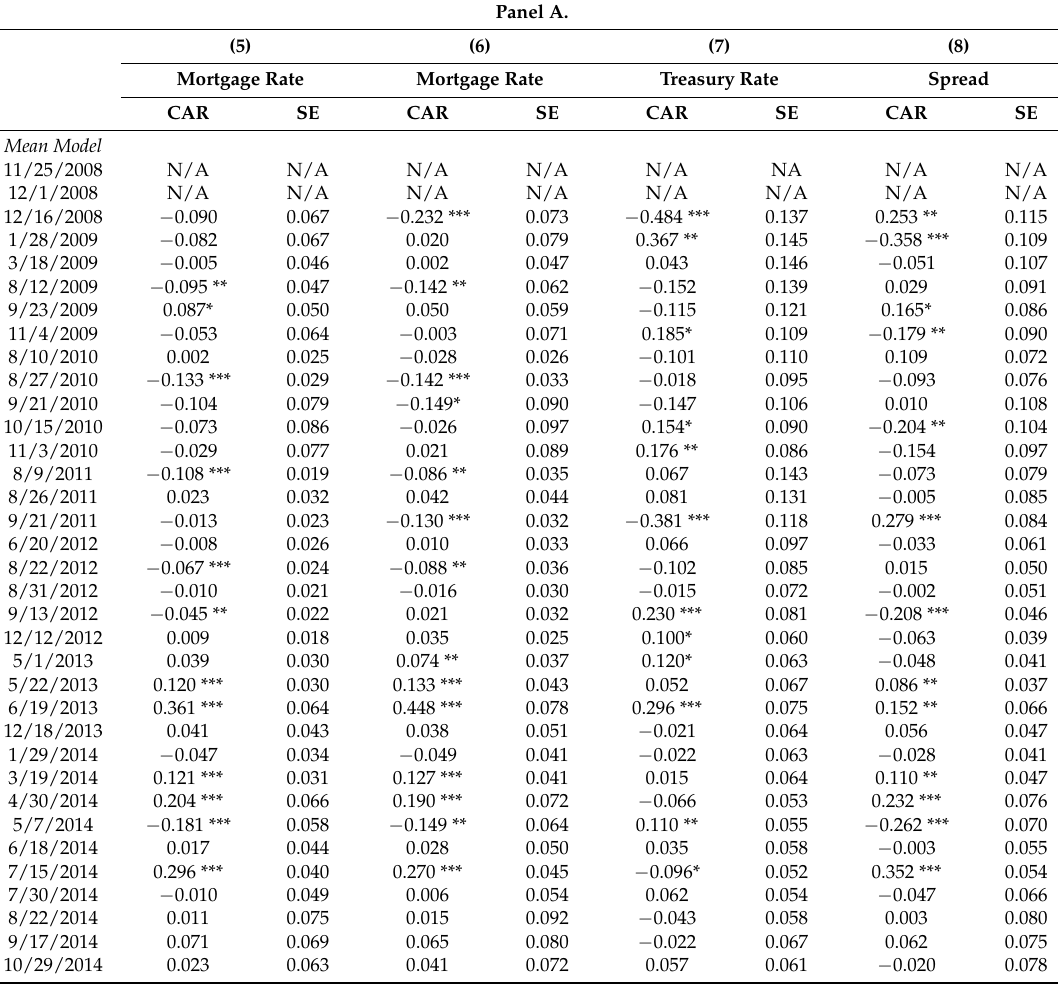
Table 3. Cumulative abnormal returns (CARs) in 5-day windows. We run four regressions (Equations (5) to (8)) with 5-day event window (i.e., t = − 2, − 1, 0, 1, 2). For each regression, the CARs and standard errors (SEs) on QE event days are reported in Panel A. Coefficient estimates and SEs of control variables and GARCH components are reported in Panel B. The CARs for 11/25/2008 and 12/1/2008 are not reported since they are